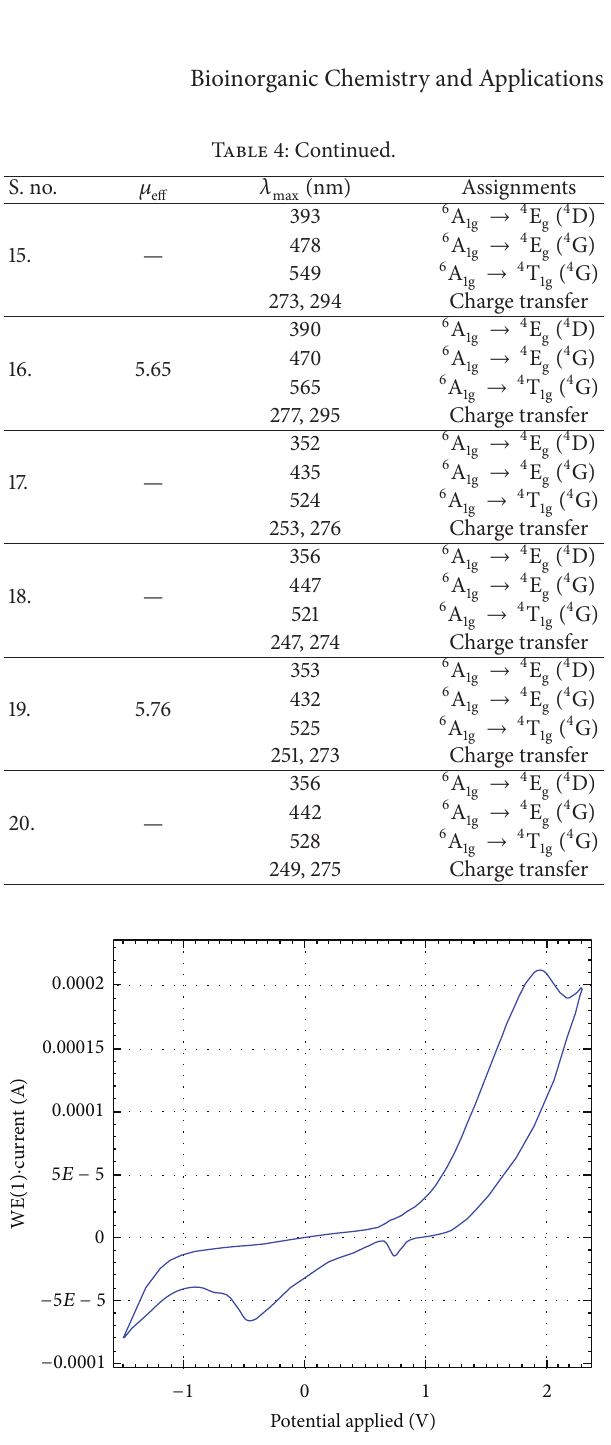
Figure 3: Cyclic voltammetric curve of complex [ { ( o -CH 3 C 6 H 4 O) 2 PS 2 } 2 Mn ⋅ 2P(C 6 H 5 ) 3 ] ( 17